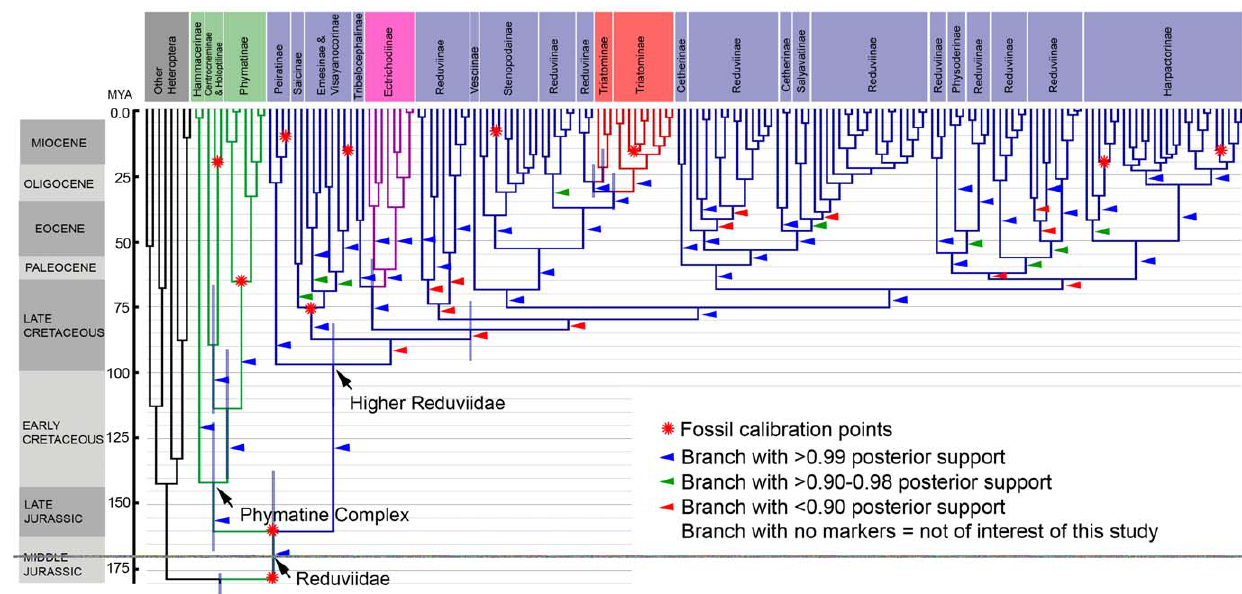
Figure 4. Divergence time estimates based on BEAST analysis using relaxed-clock model and 11 fossil calibration points. Chronogram based on same G-INS-i aligned molecular dataset (178 taxa; 5 gene regions: 16S, 18S, 28S D2, 28S D3–D5, Wg), using unlinked substitution models (GTR + C + I), relaxed clock uncorrelated lognormal and 11 fossils as priors. Lineages are colored on the chronogram as follows: Outgroup taxa (black), Phymatine Complex (green), Ectrichodiinae (pink), Triatominae (red), all other reduviid subfamilies (blue). Posterior probabilities are indicated on branches by colored triangles (see inset). Shaded node bars indicate 95% highest posterior density (HPD) credibility intervals for clades of interest only. Placement of fossils as calibration points of clades indicated by red stars.